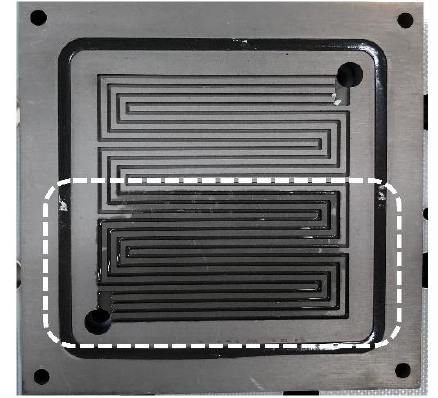
Figure 11. Channel-type flow field after dead-ended operation (anode side).